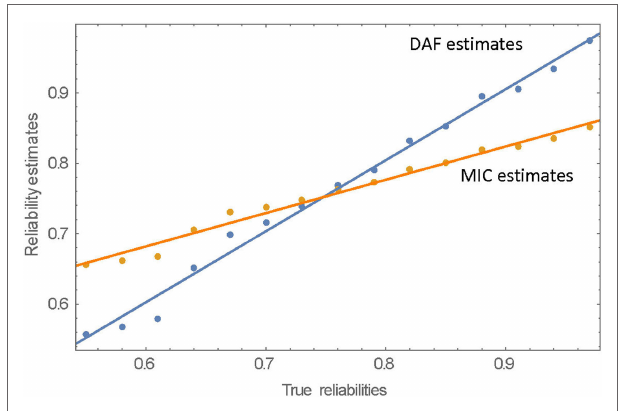
FigUre 3 | MIC and DAF estimates as a function of true reliability.